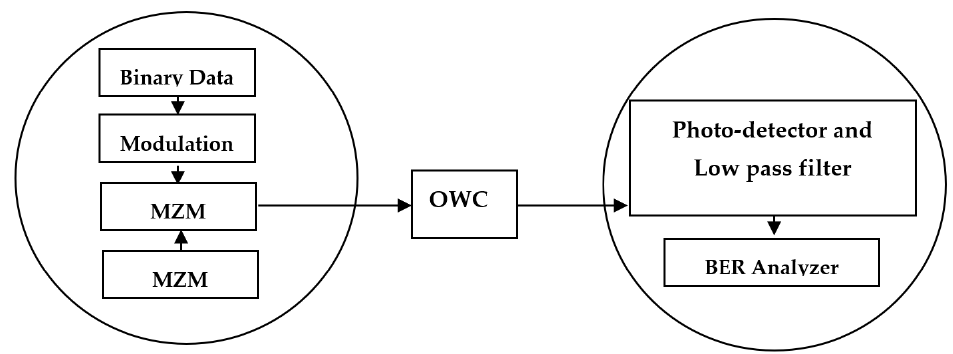
Figure 1. General representation of OSC link.